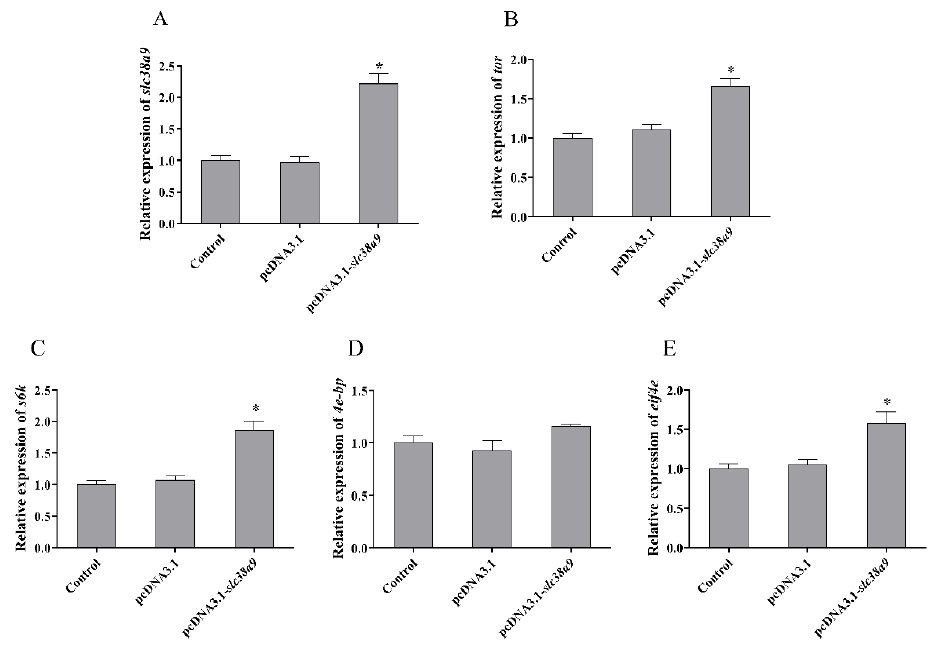
Figure 4. Effect of slc38a9 overexpression on the TOR signaling pathway in abalone. The relative expression levels of ( A ) slc38a9 , ( B ) tor , ( C ) s6k , ( D ) 4e-bp and ( E ) eif4e in abalones after injection with plasmid. Results are represented as mean ± SEM (N = 3 replicate experiments), and asterisk (*) indicates a significant difference compared with the control group ( p < 0.05).